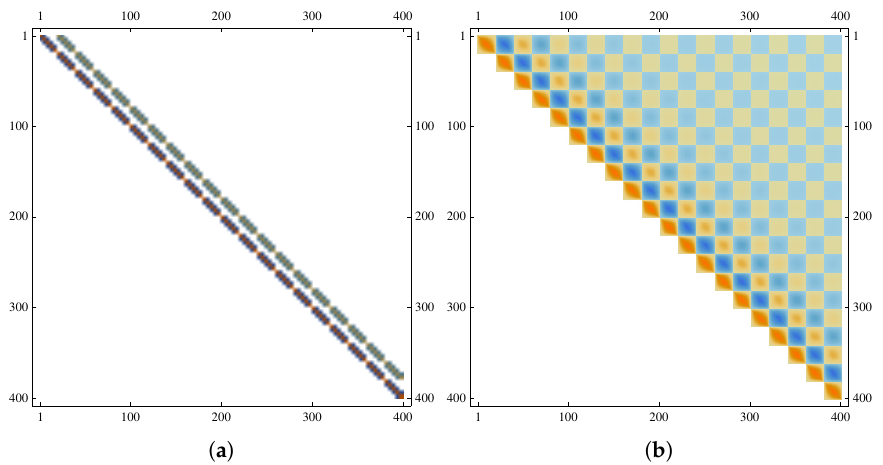
Figure 9. Representation of the ( a ) matrix and ( b ) inverse matrix for Example (7) case ( a ), when p = q = 20,